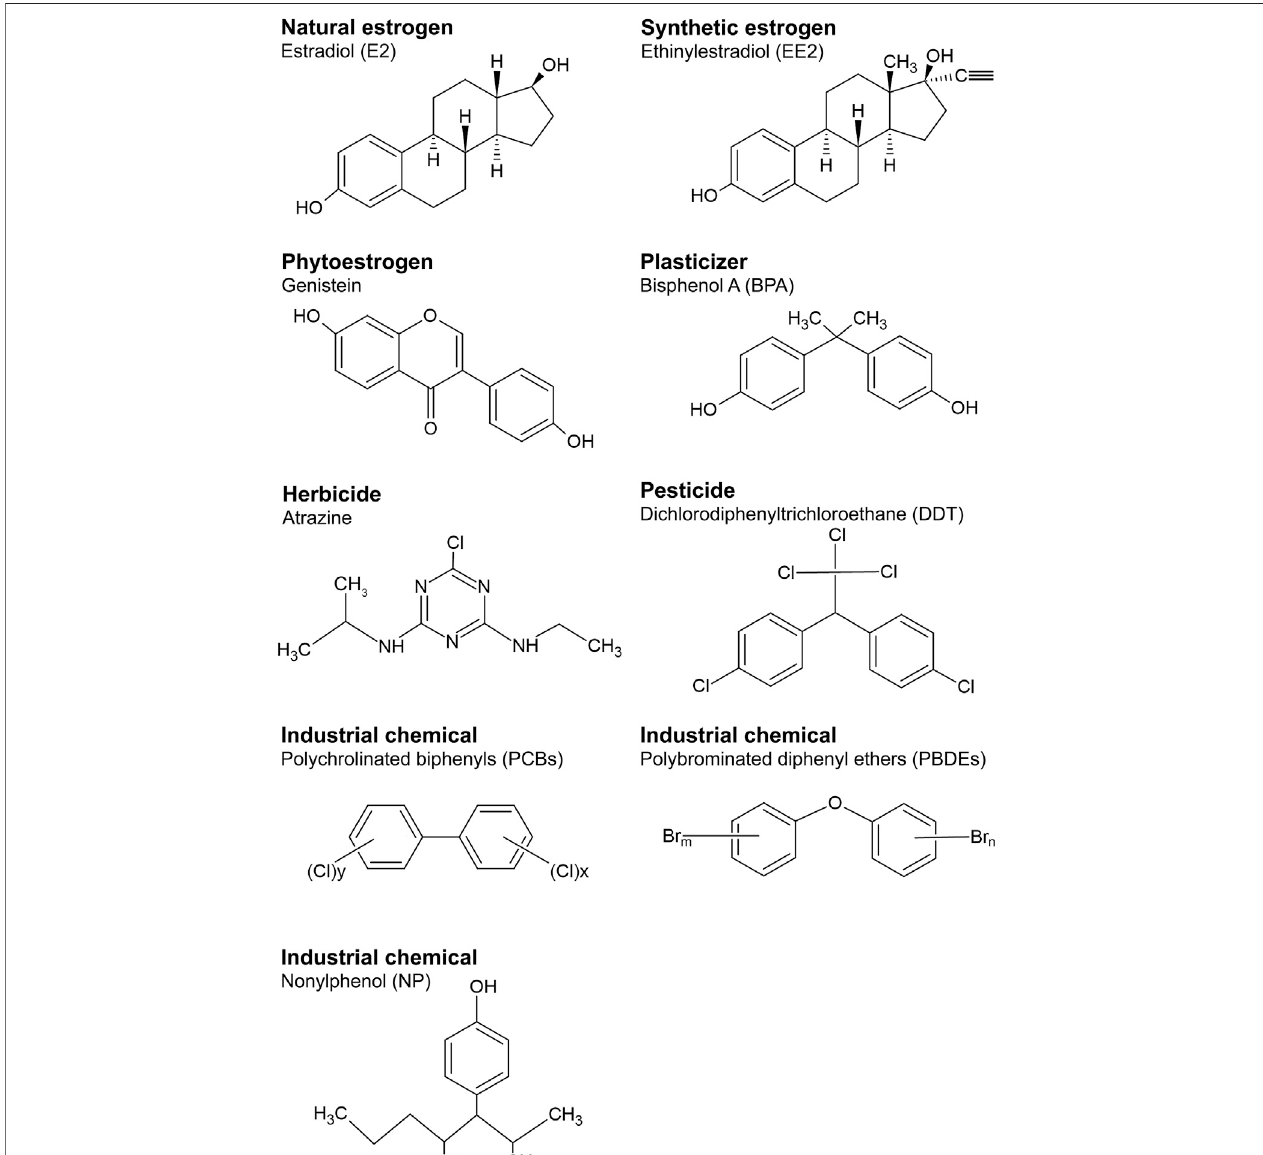
FIGURE 1 | Structures of representative chemicals of natural and synthetic estrogens and eEDC subclasses.